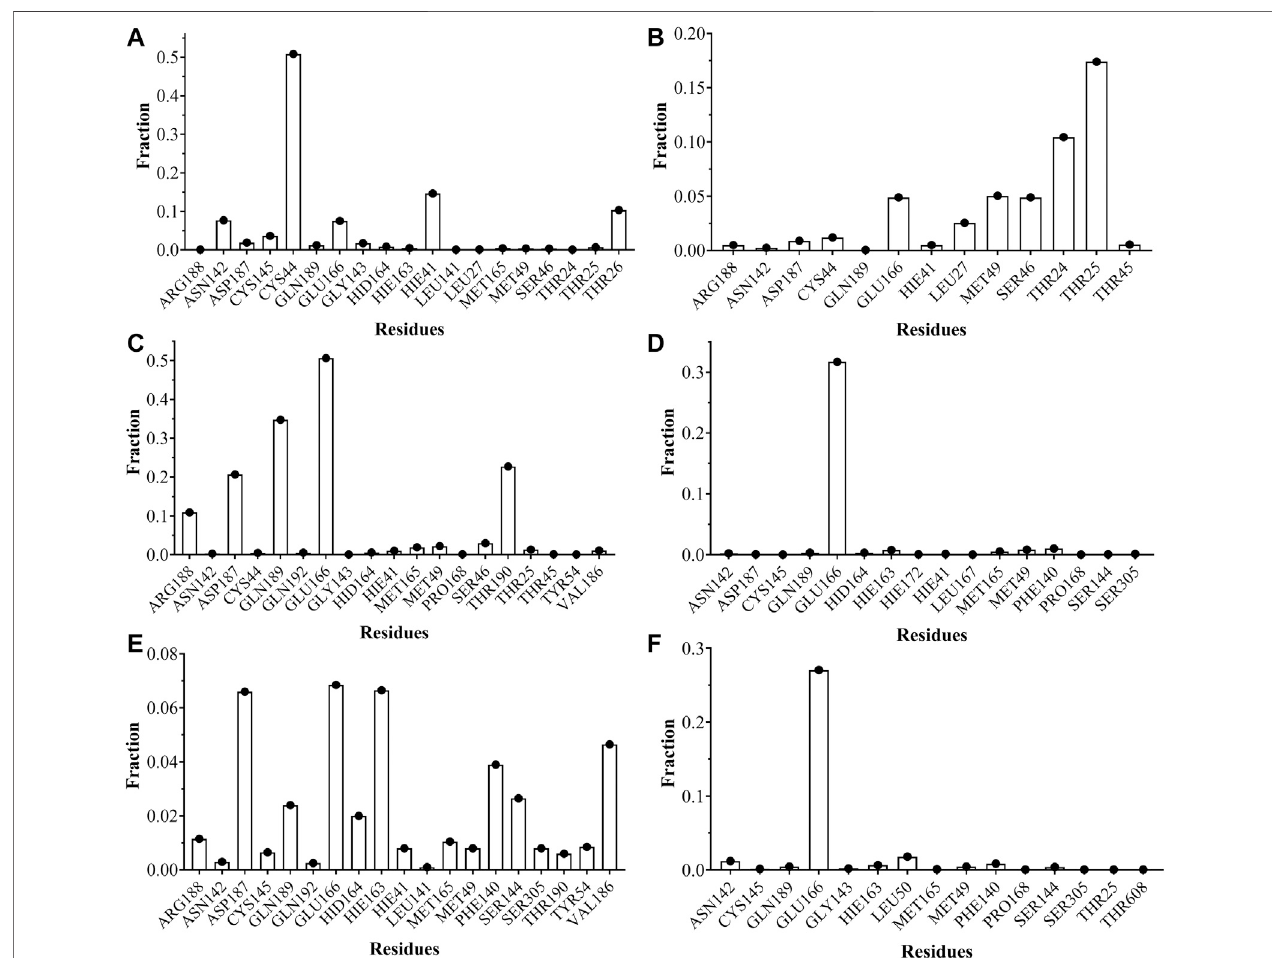
FIGURE 6 | Fraction of intermolecular hydrogen bonds for SARS-CoV-2 M pro interacting with (A) CTR9, (B) 7HC6, (C) CTR6, (D) 7HC3, (E) 8HQ6 and (F) 7HC5. The graph bar shows the most common hydrogen bonds formed between the residues on the pocket and the inhibitors. Values obtained from CPPTRAJ script in